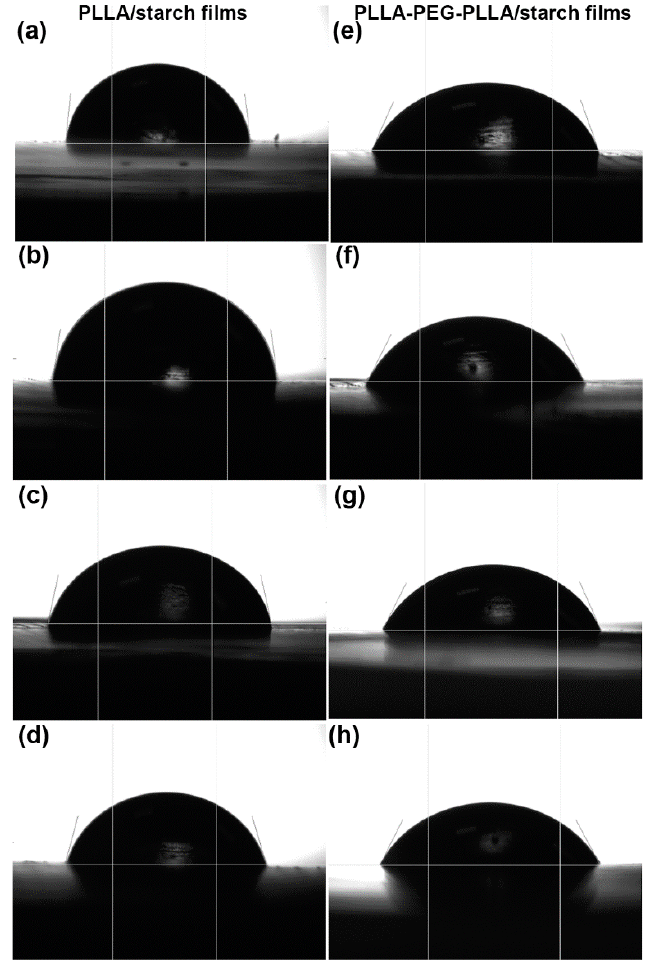
Figure 9. Images of water contact angles of ( a ) pure PLLA film and PLLA/starch films with blend ratios of ( b ) 95/5, ( c ) 90/10 and ( d ) 80/20 ( w/w ), as well as ( e ) pure PLLA-PEG-PLLA film and PLLA-PEG-PLLA/starch films with blend ratios of ( f ) 95/5, ( g ) 90/10 and ( h ) 80/20 ( w/w ).